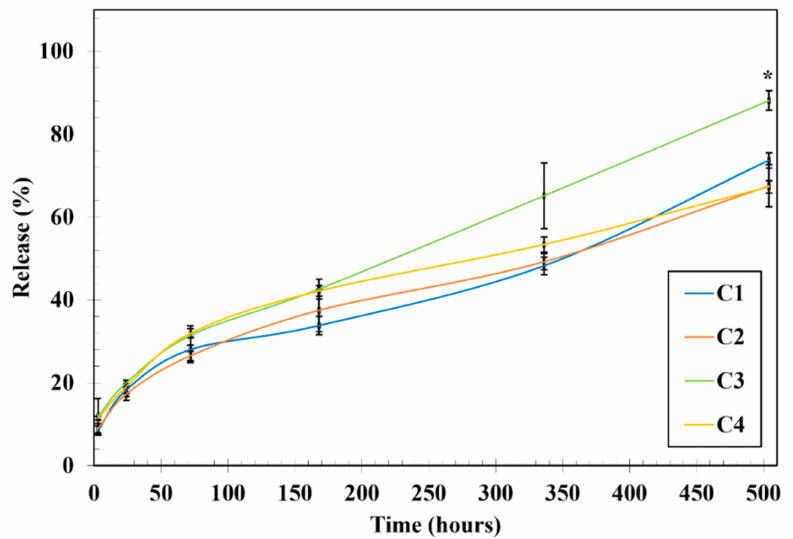
Figure 3. Release profile of anti-TNF α Ab-CS/ PAMAM dendrimer NPs. Release profile of anti-TNF α Ab-CS/ PAMAM dendrimer NPs from Ty-GG (C1 and C2) and Ty-GG/SF hydrogels (C3 and C4) with different crosslinking levels after 3, 24, 48, 72, 168, 336, and 504 h. Data shown as Mean ± SD. * indicates significant differences when comparing C3 and C4 at time point 504